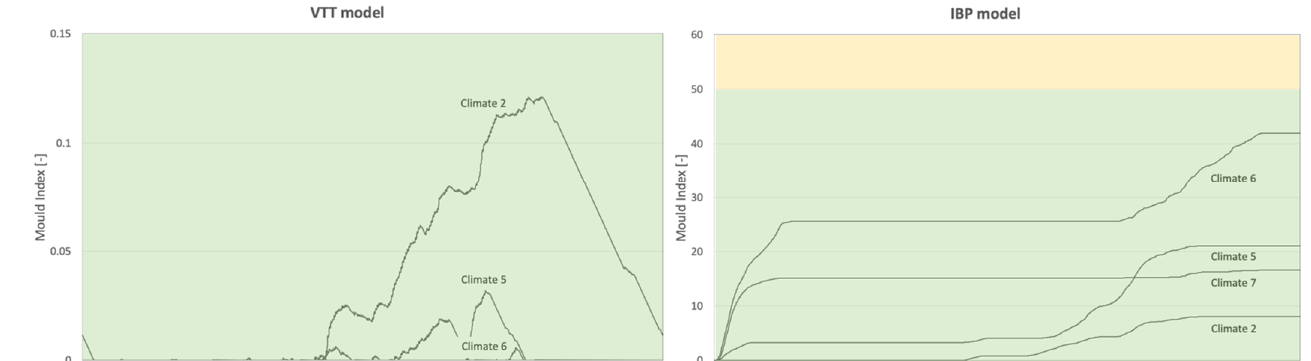
Figure 3. Mould Index value of the reference scenario in the different climates assessed with VTT and IPB model; only the values for the most critical interface are reported (most critical interface: external surface of the insulation layer).